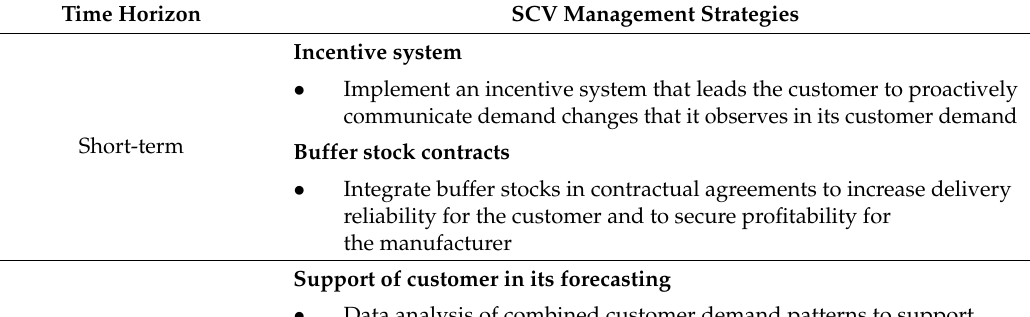
Table 9. SCV management strategies dealing with erratic behavior of